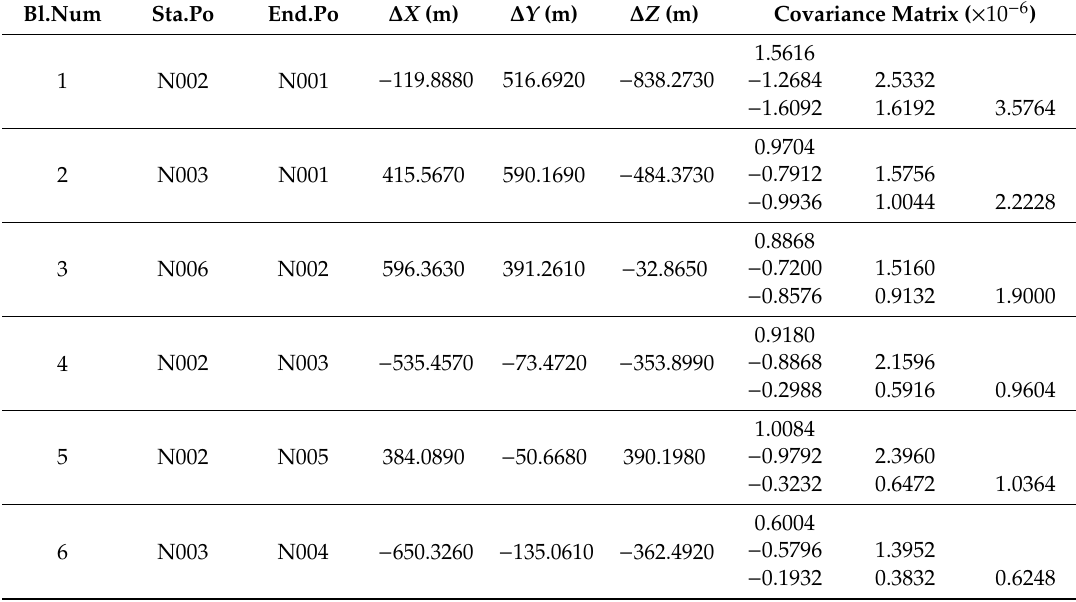
Table A1. Baseline vector observations and covariance